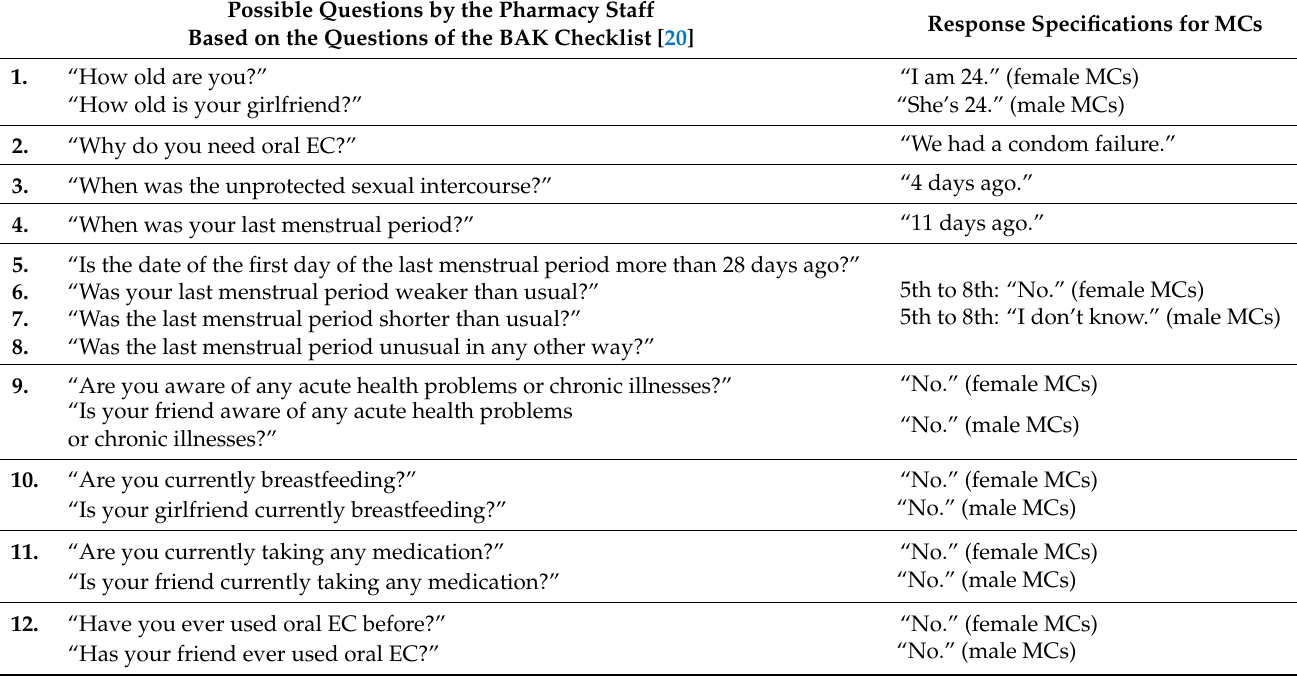
Table 1. Sub-scenario 1 for female and male MCs (without the possible